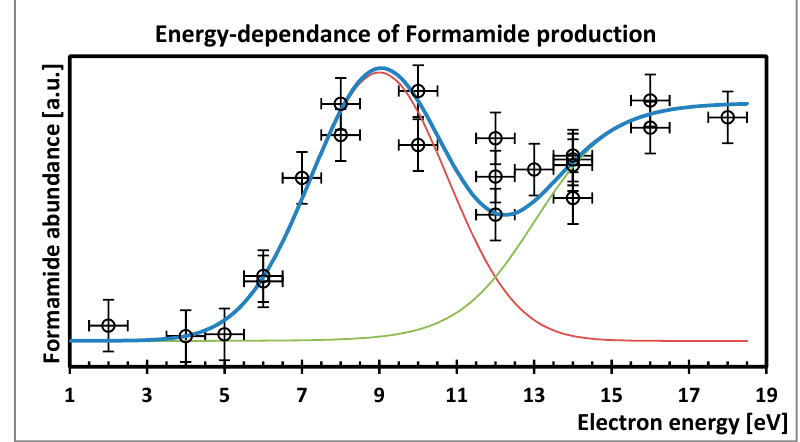
Figure 6. The production of formamide present in mixed multilayer films of CO and NH 3 . The resonance like feature (red line) between 6 and 12 eV is characteristic of the synthesis of formamide by reactants prepared in a DEA process, Bredehöft et al. [71].